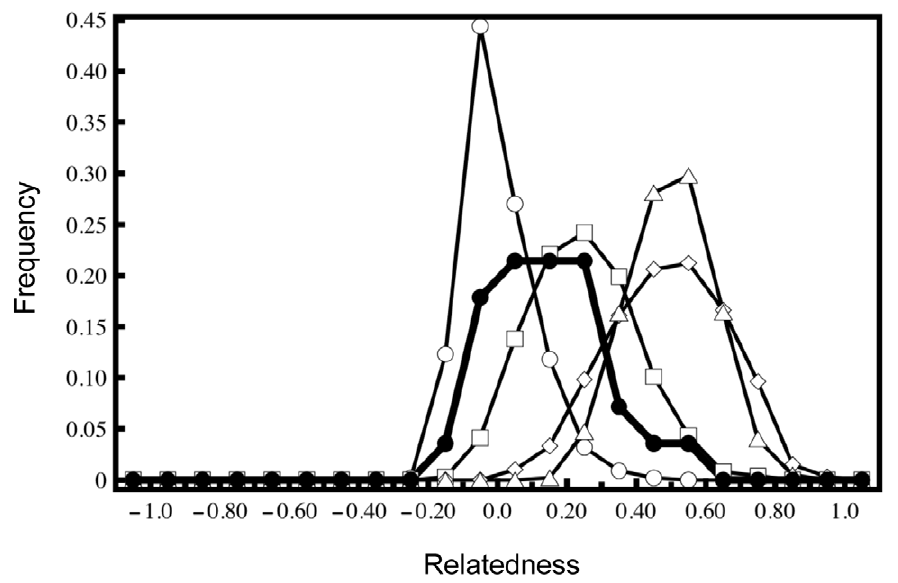
N ) overlaid upon those calculated from 1000 simulated unrelated